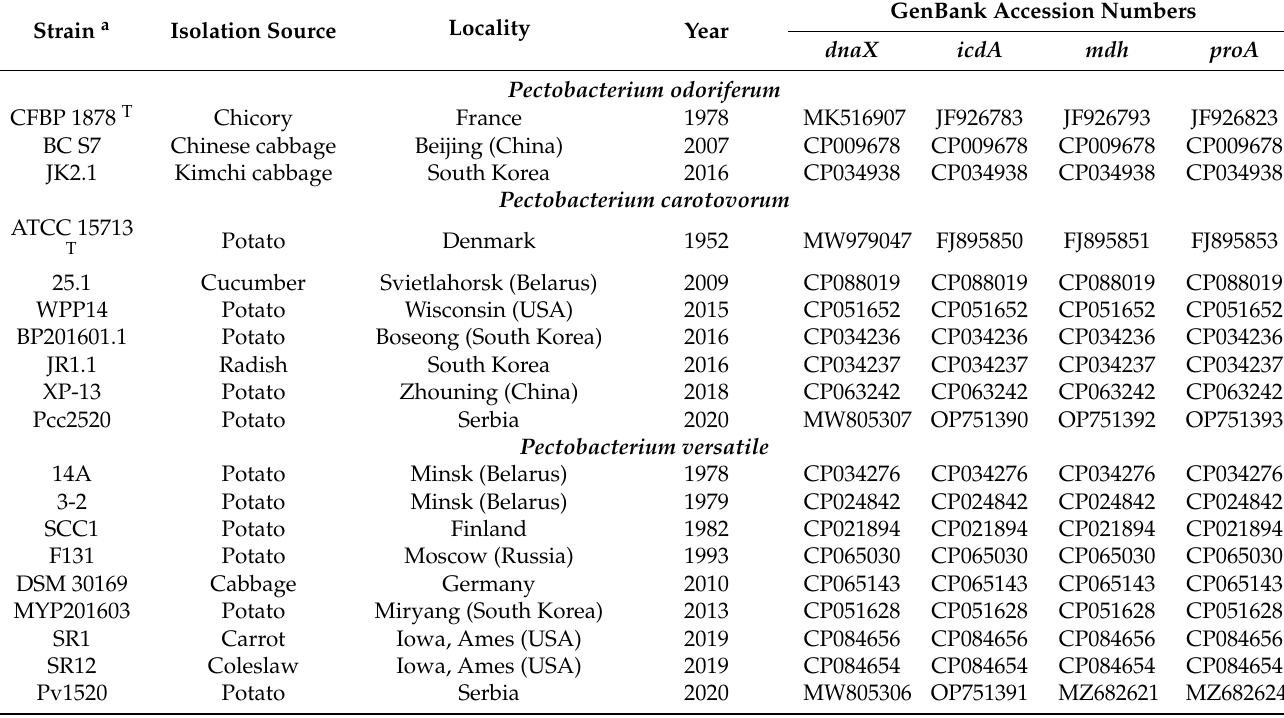
Table 2. List of the comparative Pectobacterium spp. strains used for phylogenetic analysis with GenBank accession